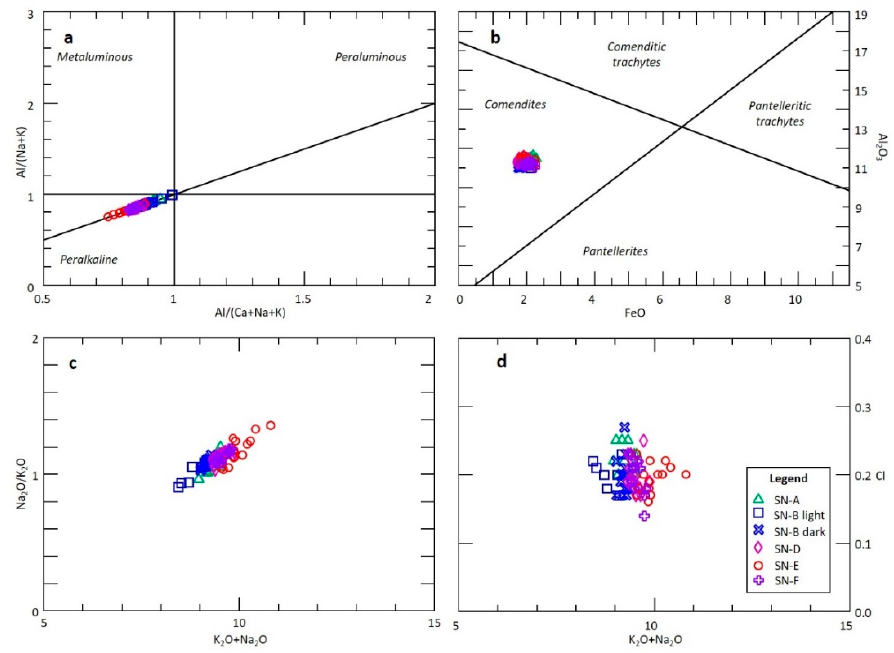
Figure 3. Chemical composition of the samples’ surface obtained by microanalysis: ( a ) classification diagram of rhyolites [27]; ( b ) [26] classification diagram for peralkaline rocks; ( c ) alkalis ratio vs. sum of alkalis; ( d ) Chlorine vs. total alkalis. Table 1. Average composition of obsidian glass obtained by EPMA.